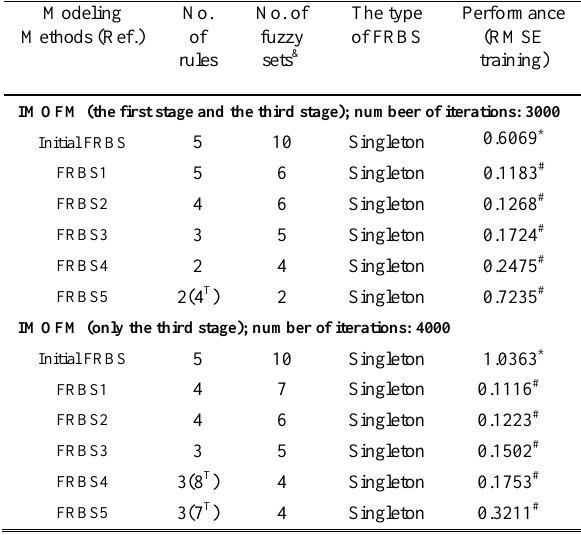
Table 2. Comparisons of the predictive performance of different modeling stages for the benchmark